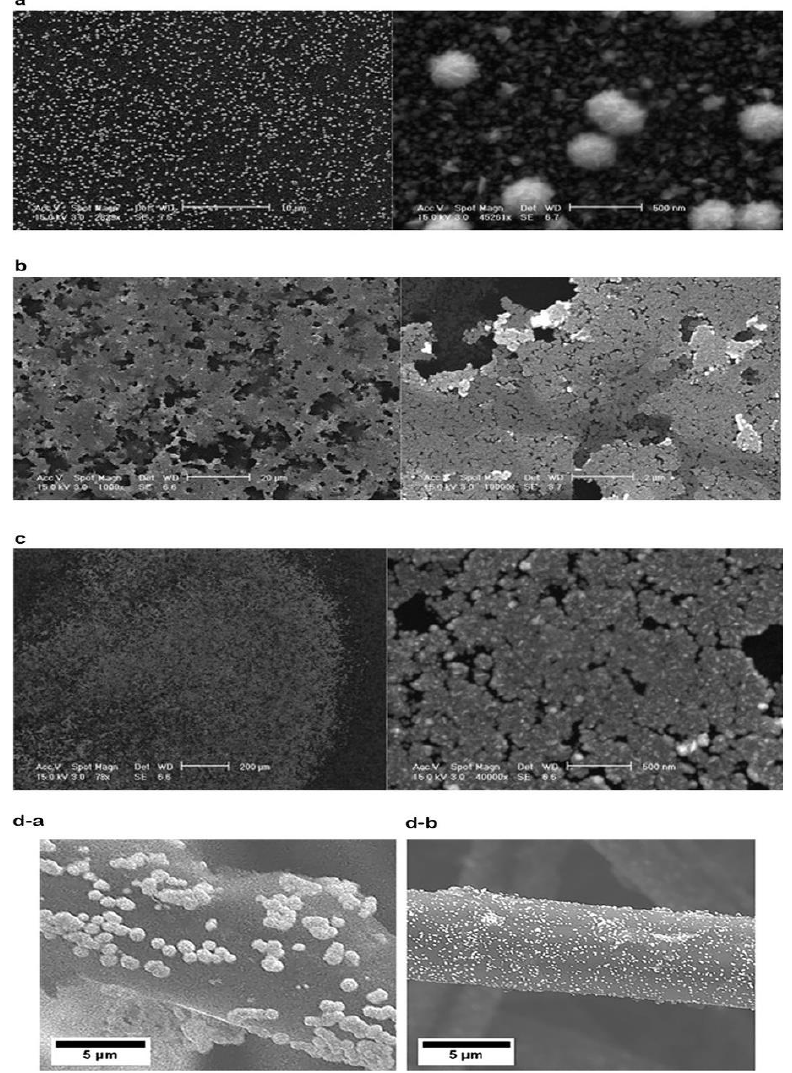
Figure 12. SEM images of Pt/GC electrodes prepared: ( a ) under silent conditions (no rotation), ( b ) under maximum rotation (2000 rpm) and ( c ) in the presence of ultrasound (2.3 W), Pt electrodeposited on GDL ( d-a ) under silent and ( d-b ) ultrasonic (4.4 W) conditions [43].